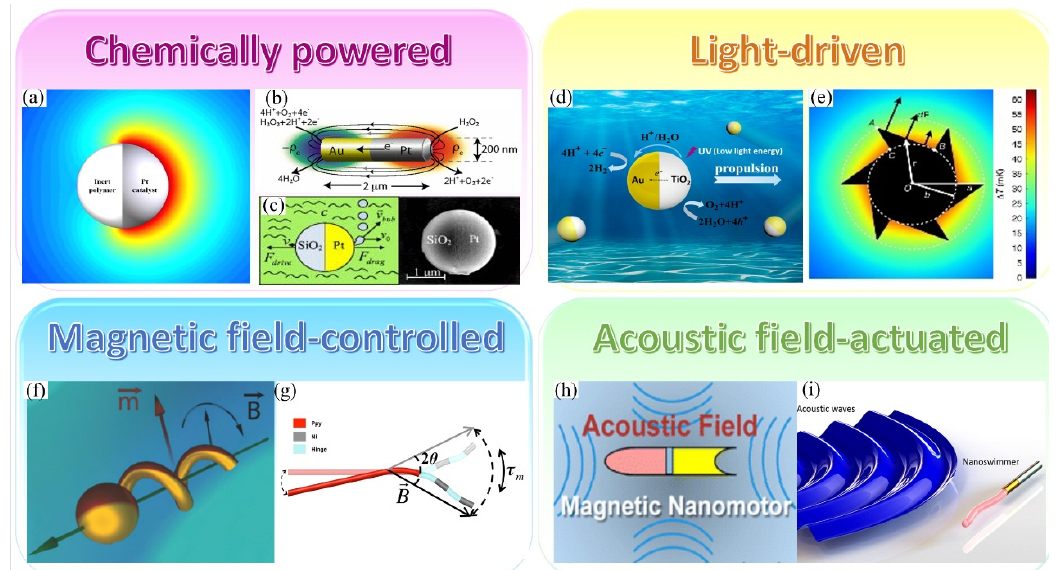
Figure 1. Four common ways to propel MNMs. ( a ) An illustration showing the chemical gradient formed around a Janus microsphere. Reprinted with permission from [33]. ( b ) Pt/Au nanorods swim through a self-electrophoresis mechanism. Reprinted with permission from [48]. ( c ) Microspheres propelled by bubble recoil. Reprinted with permission from [51]. ( d ) An illustration showing motile microspheres driven by photocatalytic reactions. Reprinted with permission from [43]. ( e ) Rotation of a microgear induced by a laser-induced thermal gradient. Reprinted with permission from [60]. ( f ) A schematic graph showing a helical micropropeller moving in a rotational magnetic field. Reprinted with permission from [67]. ( g ) A schematic graph showing a multi-linked nanowire moving in an oscillating magnetic field. Reprinted with permission from [71]. ( h ) An illustration of an acoustic field-powered nanowire with magnetic navigation. Reprinted with permission from [65]. ( i ) A schematic graph showing a nanowire powered by travelling acoustic waves. Reprinted with permission from [75].